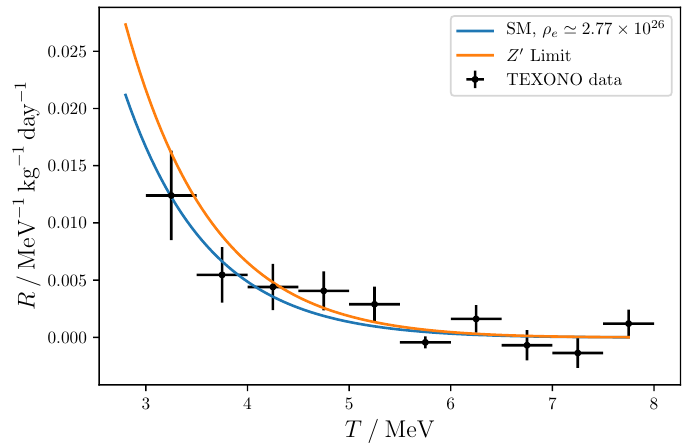
Figure 6 . Data of the TEXONO experiment (neutrino rate R in units of MeV (cid:0) 1 kg (cid:0) 1 day (cid:0) 1 as a function of the binned recoil energy T ) [119], to which we superimpose our SM and Z 0 predictions, respectively corresponding to blue and orange